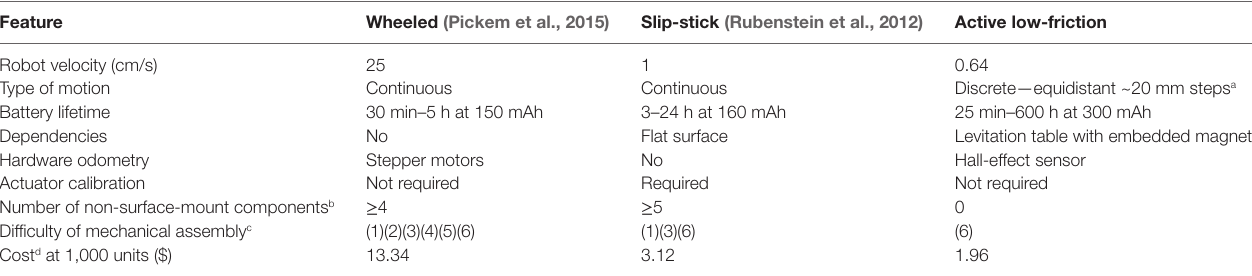
TaBle 2 | Comparison of wheeled, slip-stick, and low-friction locomotion.